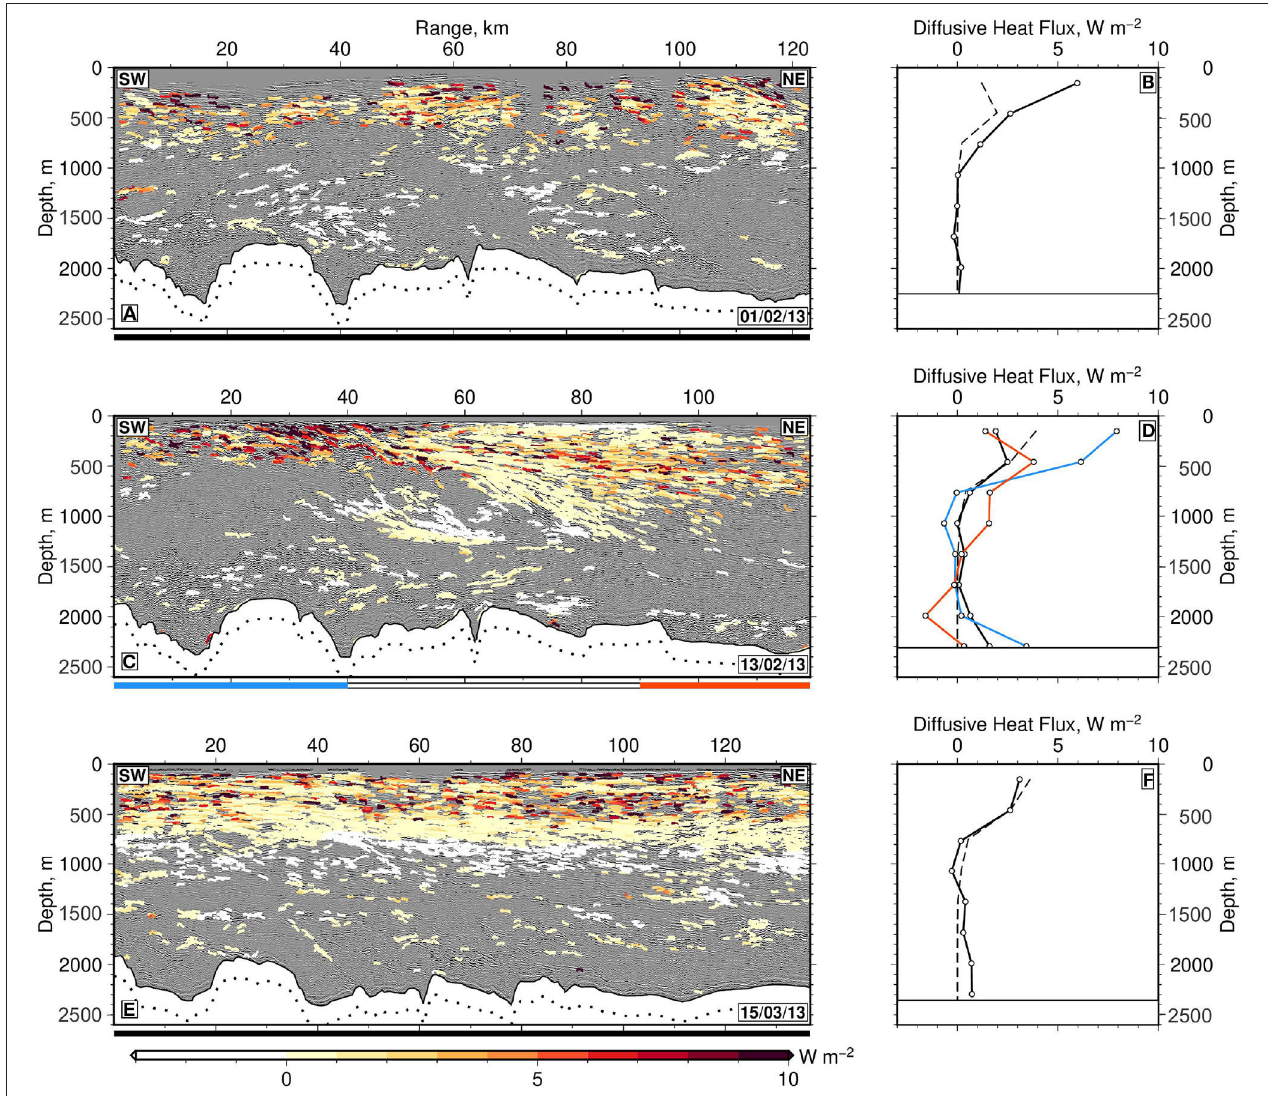
FIGURE 9 | (A) Section A of seismic reflection survey overlain with spatial distribution of vertical diffusive heat flux, F H , calculated using seismically determined mixing estimates and temperature distribution. Colored wiggly lines = 1,017 auto-tracked reflections where color indicates value of F H according to scale bar at base of (E) . Positive values indicate downward-directed heat flux and uncertainty in F H is 3 W m − 2 . Black bar along base of image = range used to calculate horizontal mean of F H reported in (B) . (B) Horizontal mean of F H in 300 m depth bins. White circles and solid black line = binned mean values of F H calculated using seismically, determined values of 2 ( z ); dashed black line = binned mean values of F H calculated using CTD-measured values of 2 ( z ) (see Figure 2A ). (C,D) Same for Section B with 1,841 tracked reflections. Blue/white/red bar along base of image = three ranges used to calculate horizontally averaged profiles of F H . (E,F) Same for Section C with 2,310 tracked